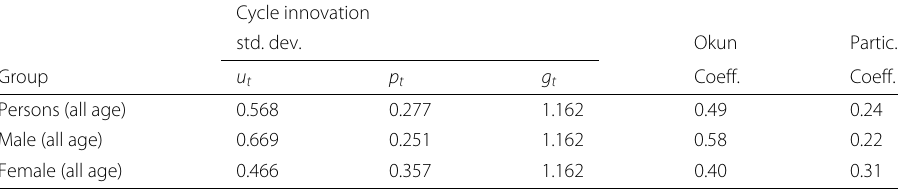
Table 4 Okun and participation coefficients derived using HP filter specification Cycle innovation std. dev. Okun Partic. Group u t g t Coeff.